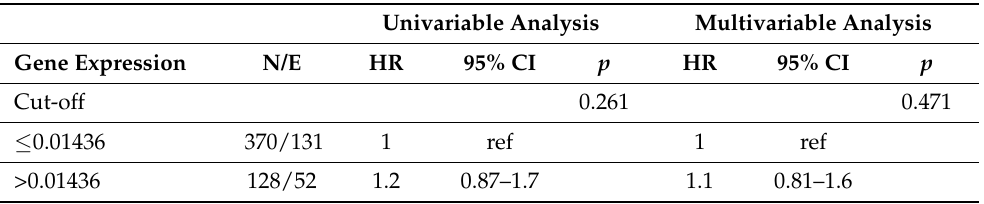
Table 16. Event Free Survival of 498 NB patients in relation to LOC339788 expression levels evaluated by the Cox model.